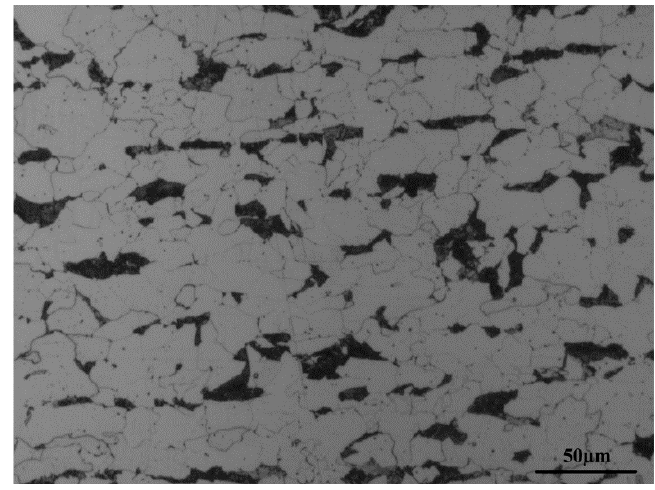
Figure 2. Metallographic structure of Q345 steel.